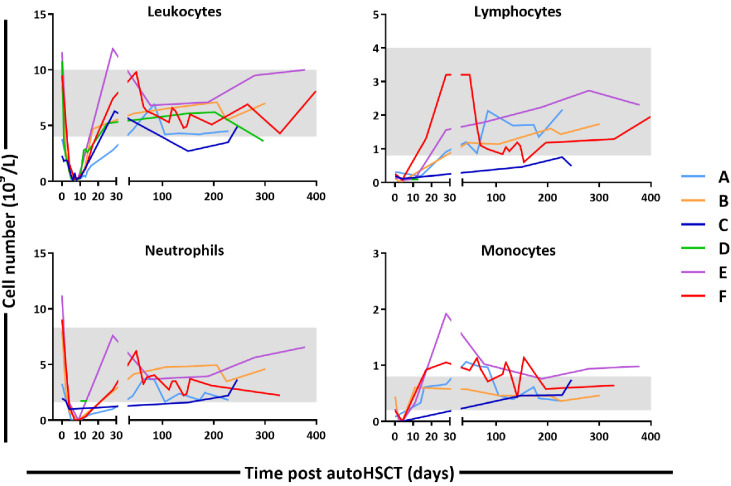
Absolute numbers (cells × 109 per liter of blood) of leukocytes, neutrophils, lymphocytes, and monocytes in peripheral blood of autologous hematopoietic stem cell transplantation (autoHSCT) patients (patients A–F) over time after autoHSCT obtained by automated blood leukocyte differential count (leukodiff).Gray areas show the range of healthy individuals’ values.